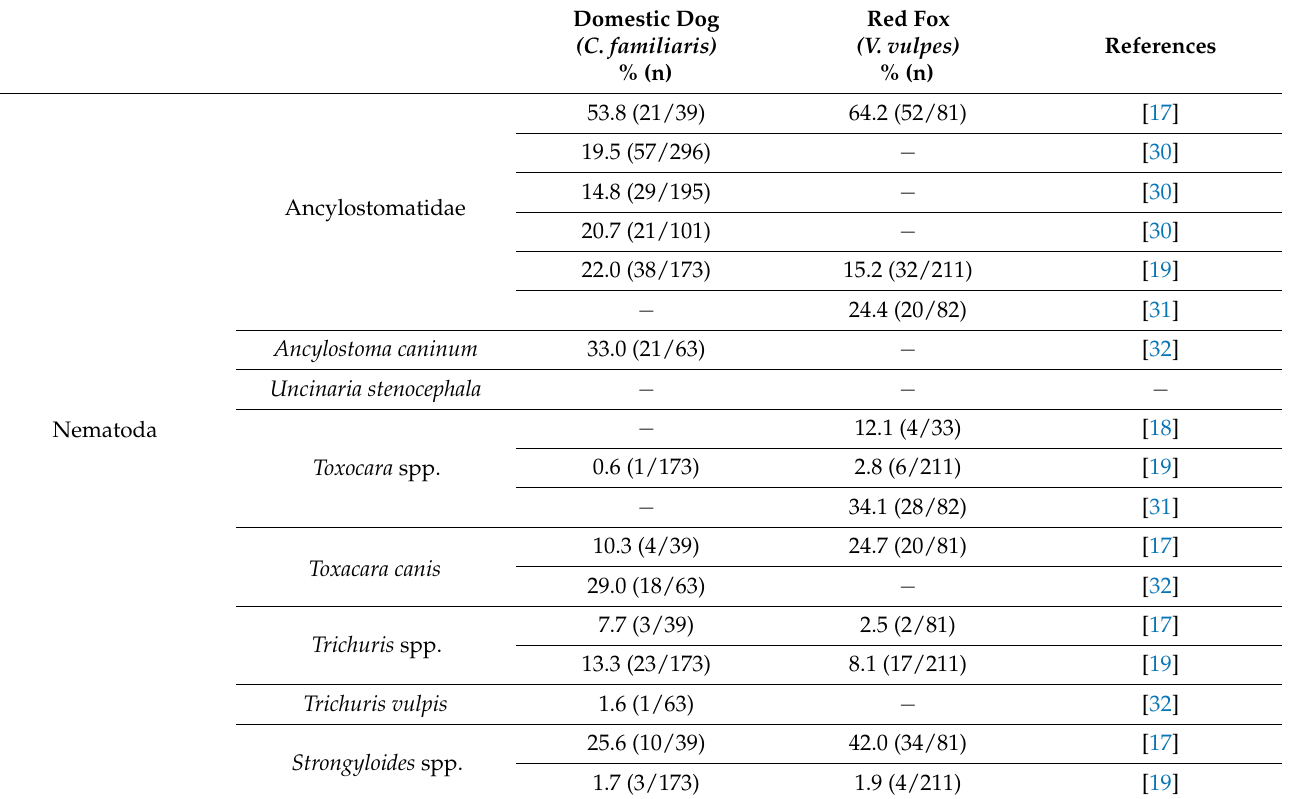
Table 4. Prevalence (%) of parasitic agents with zoonotic potential reported in domestic dogs (